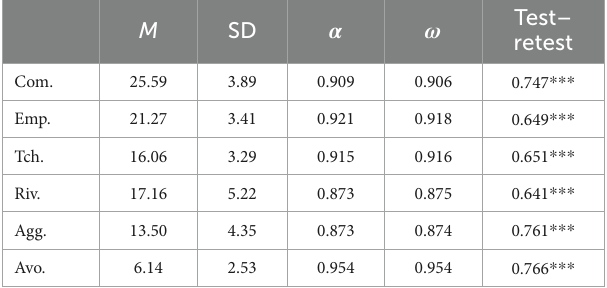
TABLE 6 Means, standard deviation, and reliability tests of